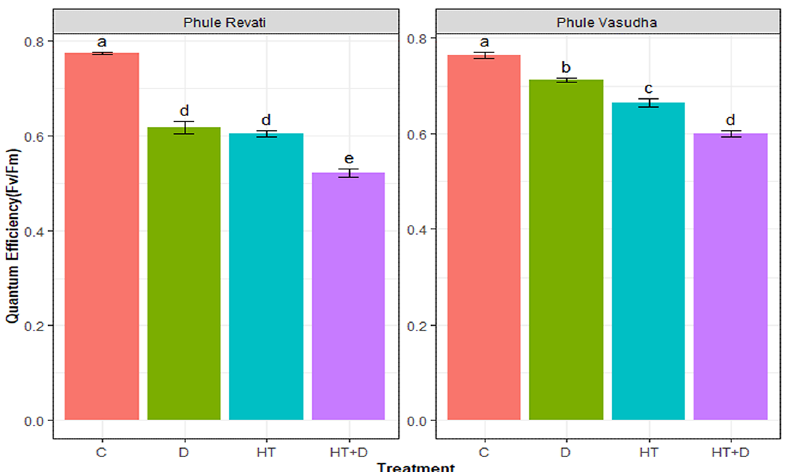
Figure 3. Quantum efficiency of PS II (F v /F m ) of Phule Revati and Phule vasudha under control (C), drought (D), heat (HT), and heat + drought (HT + D) stress at ( a ) 5th day after stress treatment and ( b ) 10th day after stress treatment. The data represent mean values ± SE (n = 8). Different small letters above the bars indicate significant differences (P < 0.05).